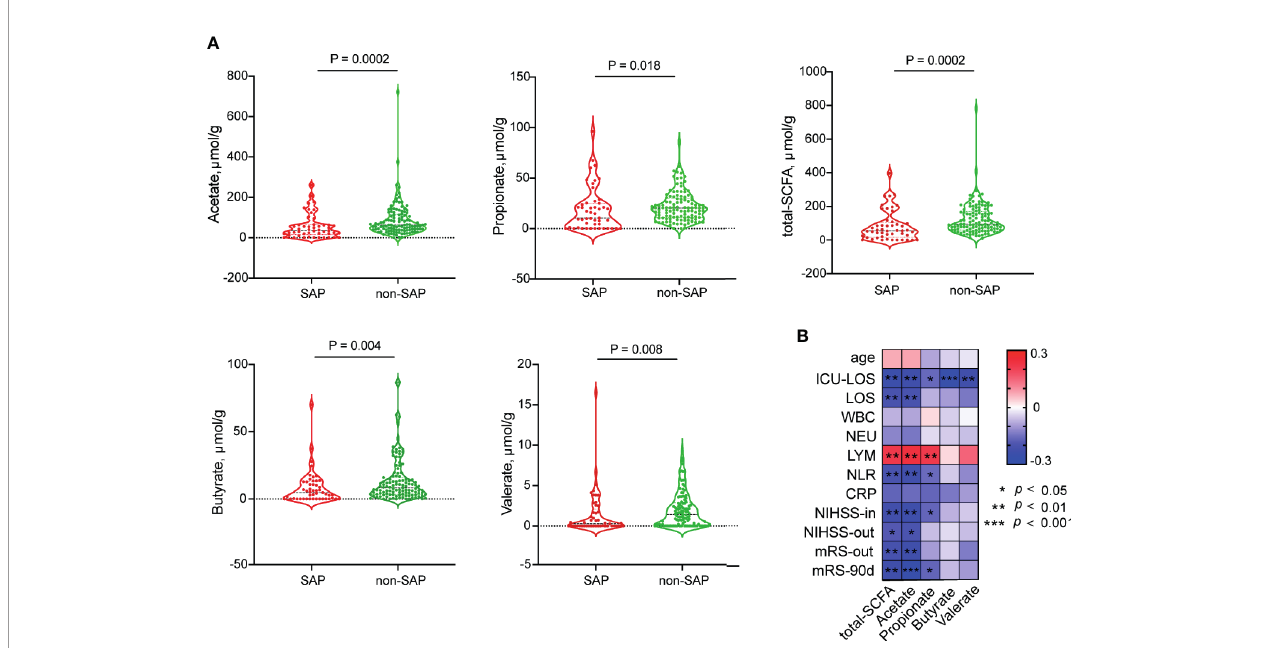
FIGURE 4 | Comparison of fecal SCFAs levels between patients with SAP and without SAP. (A) Decreased fecal SCFA, including acetate; propionate; butyrate and valerate, were in the SAP group than in the non-SAP group. (B) Spearman ’ s Correlation of SCFAs with clinical